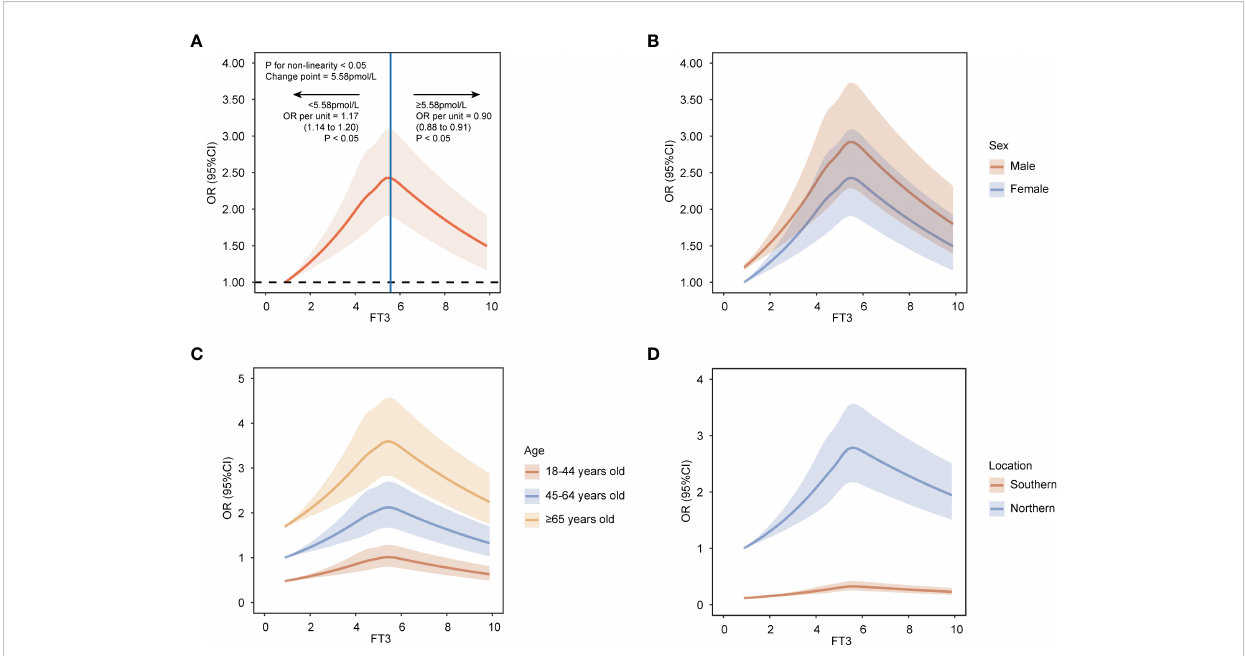
FIGURE 2 Restricted cubic spline analyses with fi ve knots for nonlinear association between FT3 levels and MAFLD on a continuous scale. (A) all population. (B) by sex. (C) by age groups. (D) by location groups. ORs are indicated by solid lines and 95% CIs by shaded areas. Reference point is lowest value for FT3. Analyses were adjusted for age, sex, heart rates, leukocyte counts, red blood cells, platelets, hemoglobin, gamma-glutamyl transpeptidase, estimated glomerular fi ltration rate, uric acid, total cholesterol, smoking status, alcohol consumption, and a history of diabetes and hypertension. FT3, free triiodothyronine; MAFLD, metabolic dysfunction-associated fatty liver disease; OR, odd ratio; CI, con fi dence